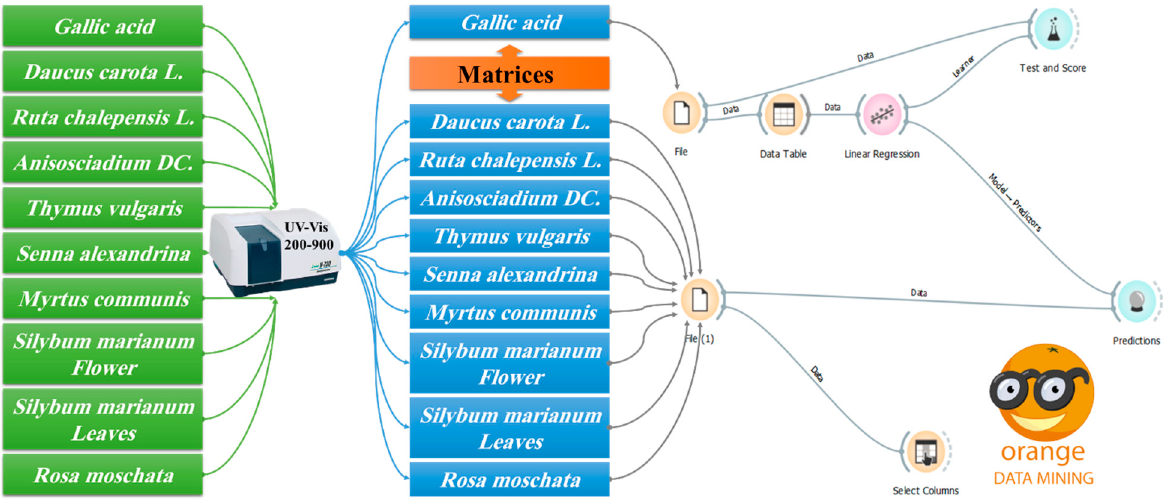
Figure 1. Flow chart showing the method steps and the workflow in Orange software to determine quantitatively the TPC in a bunch of plant extracts.